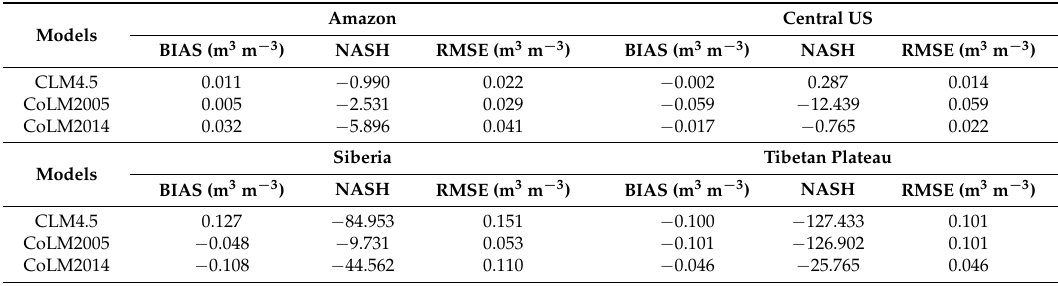
Figure 7. Annual mean spatial distributions of surface soil moisture simulated by ( a ) CLM4.5; ( b ) CoLM2005; and ( c ) CoLM2014; Along with spatial distributions of biases relative to the validation standard for ( d ) CLM4.5; ( e ) CoLM2005; and ( f ) CoLM2014 (Units: m 3 m − 3 ). Table 4. Statistical summary of simulated soil moisture annual cycles.